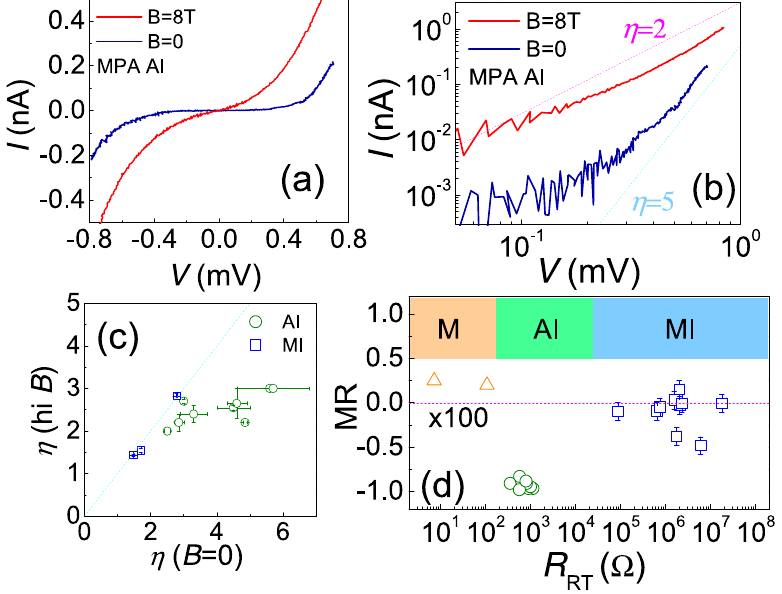
Figure 6. ( a ) The IV characteristics of an MPA AI device at B = 0 (blue curve) and B = 8 T (red curve) at 50 mK; ( b ) log-log plot of the IV curves in ( a ). The IV exponent η reduces from ~5 to ~2 when B is elevated from 0 to 8 T; ( c ) the change of IV exponent η from zero fields to the high field (MI at B = 9 T, AI at B = 8 T); ( d ) a summary of MR as a function of RT resistance. Metallic devices exhibit a small, typical 0.2% positive MR at B ~ 3T ( T < 100 mK). MIs do not present magnetic response at the high field of B = 9 T ( T > 2 K). For AIs, the zero bias resistance may be reduced as much as 10 times by a large field, B = 8 T ( T < 100 mK).